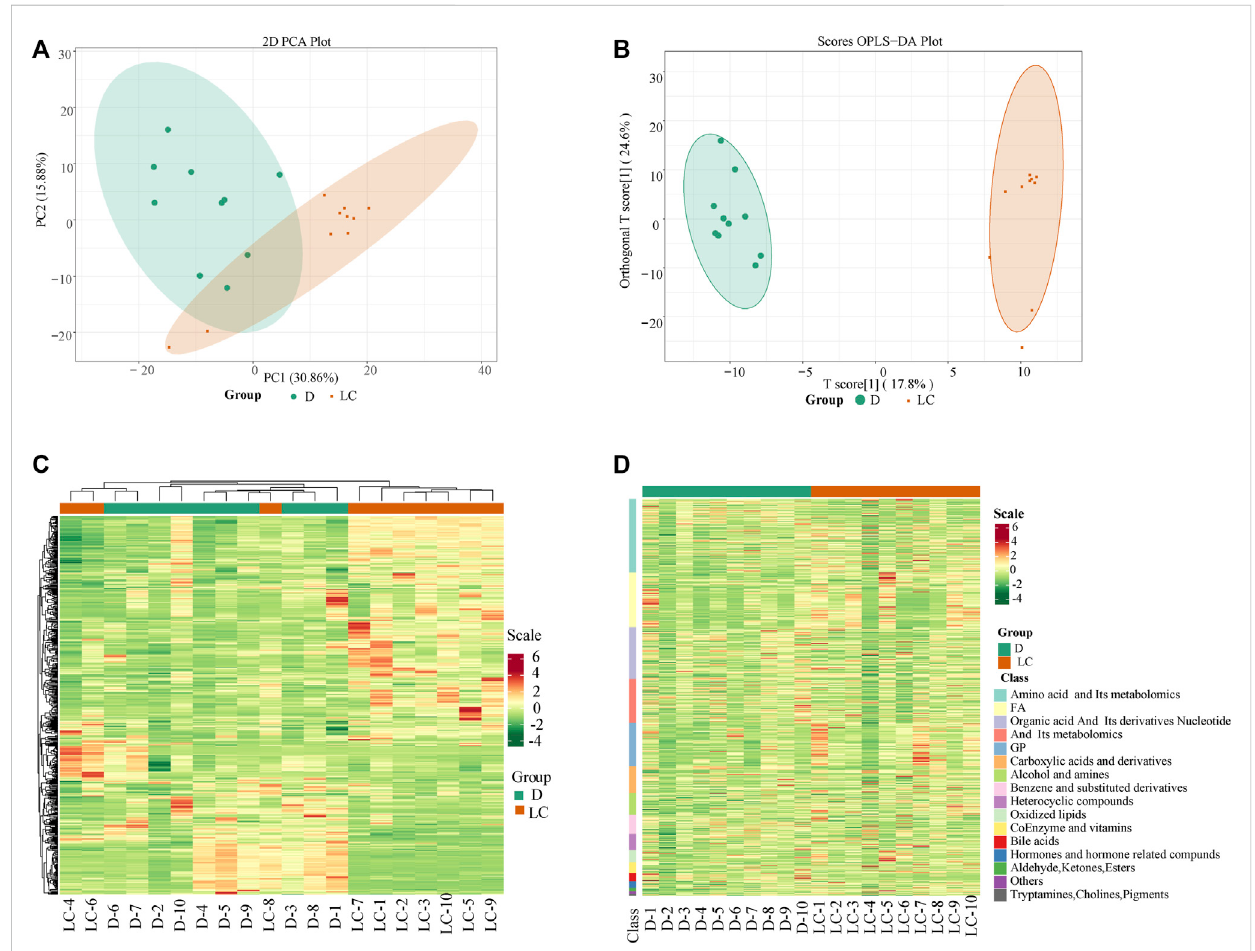
FIGURE 1 Multivariate and cluster analyses results of Duroc and Luchuan skeletal muscle metabolites. (A) PCA analysis of metabolites detected in Duroc and Luchuan samples. Duroc is highlighted in green and Luchuan in orange. (B) OPLS-DA score plot demonstrates separation of the Duroc and Luchuan groups. (C) Hierarchical cluster analysis of metabolites from Luchuan and Duroc samples. The color represents accumulation of metabolites, from low (green) to high (red). The Z score scale marks the deviation from the mean by standard deviation units. (D) Heatmap of all DAMs. The metabolites were classi fi ed into 16 classes, and the colors display the abundance of